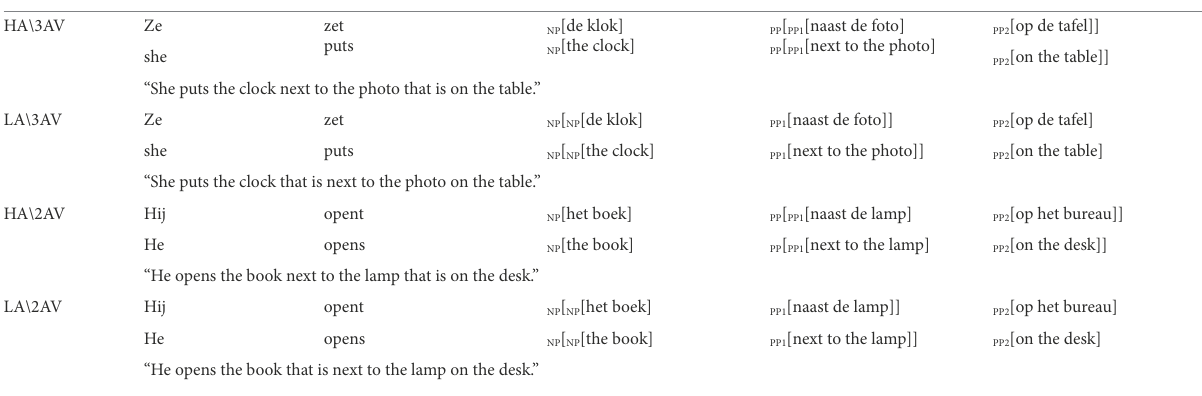
TABLE 1 The conditions for the presentation of experimental